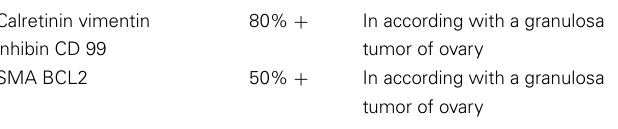
Table 3 | Positive markers of tumor (B)